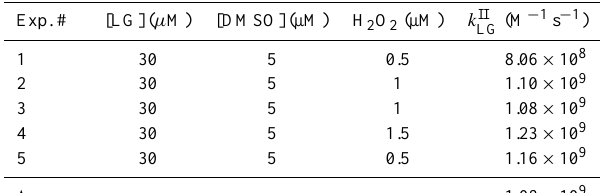
Table 1. Summary of the conditions and the results of the kinetic